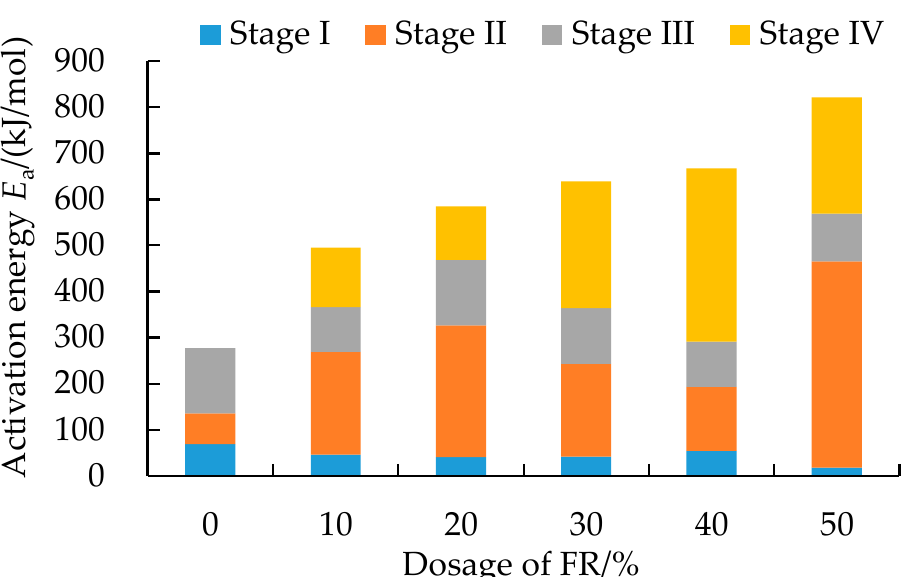
Figure 6. Apparent activation energy of FRA.